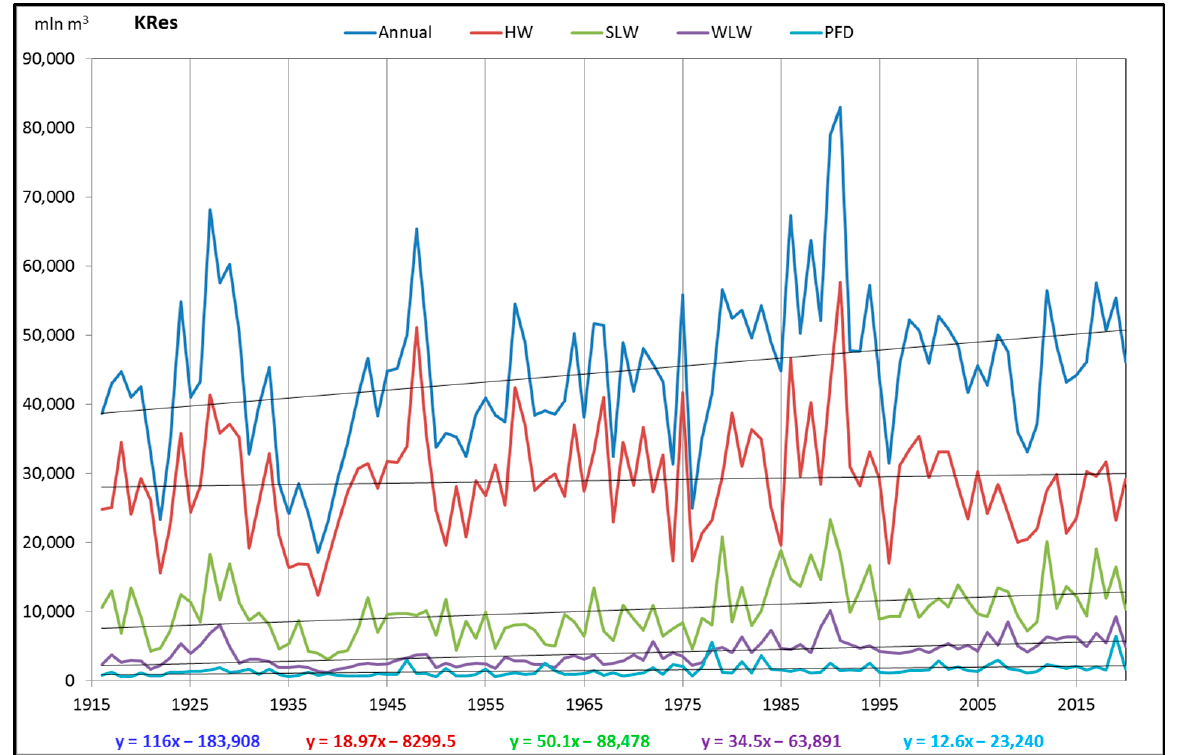
Figure 3. Annual and seasonal inflow—Kuibyshevskoye reservoir.